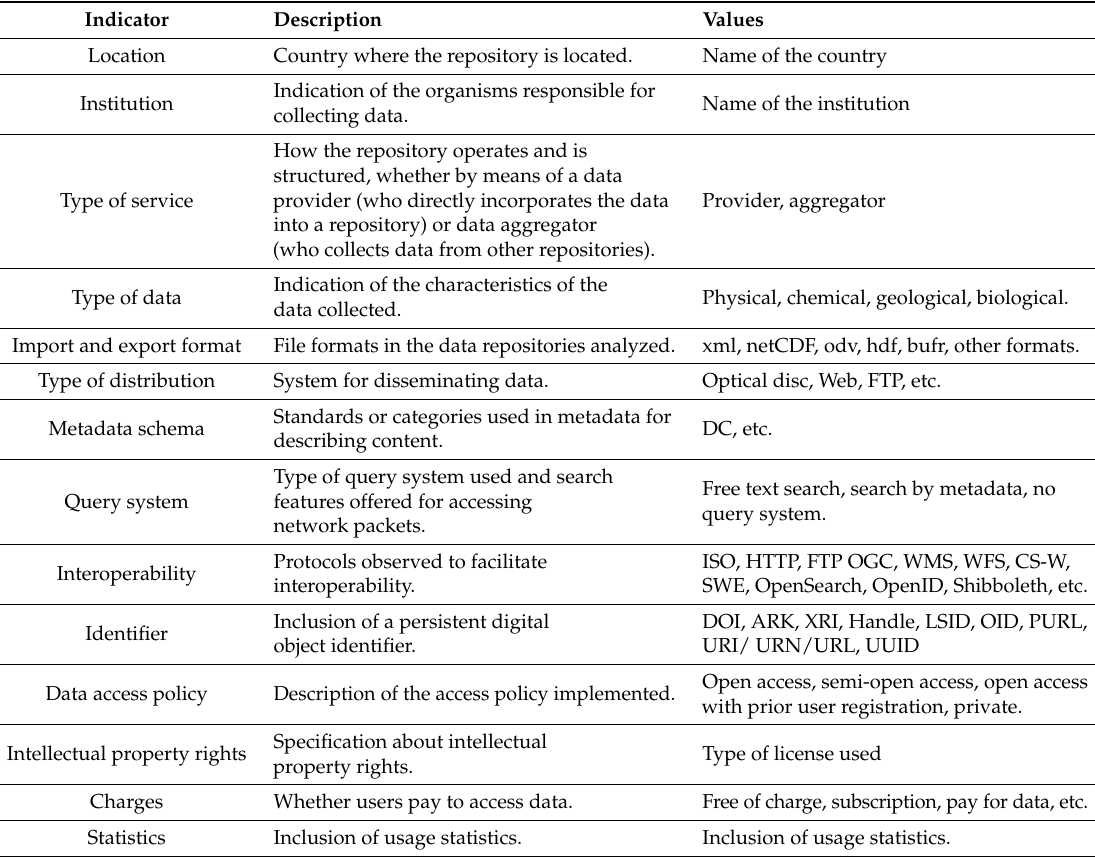
Table 2. Indicators for the analysis of data